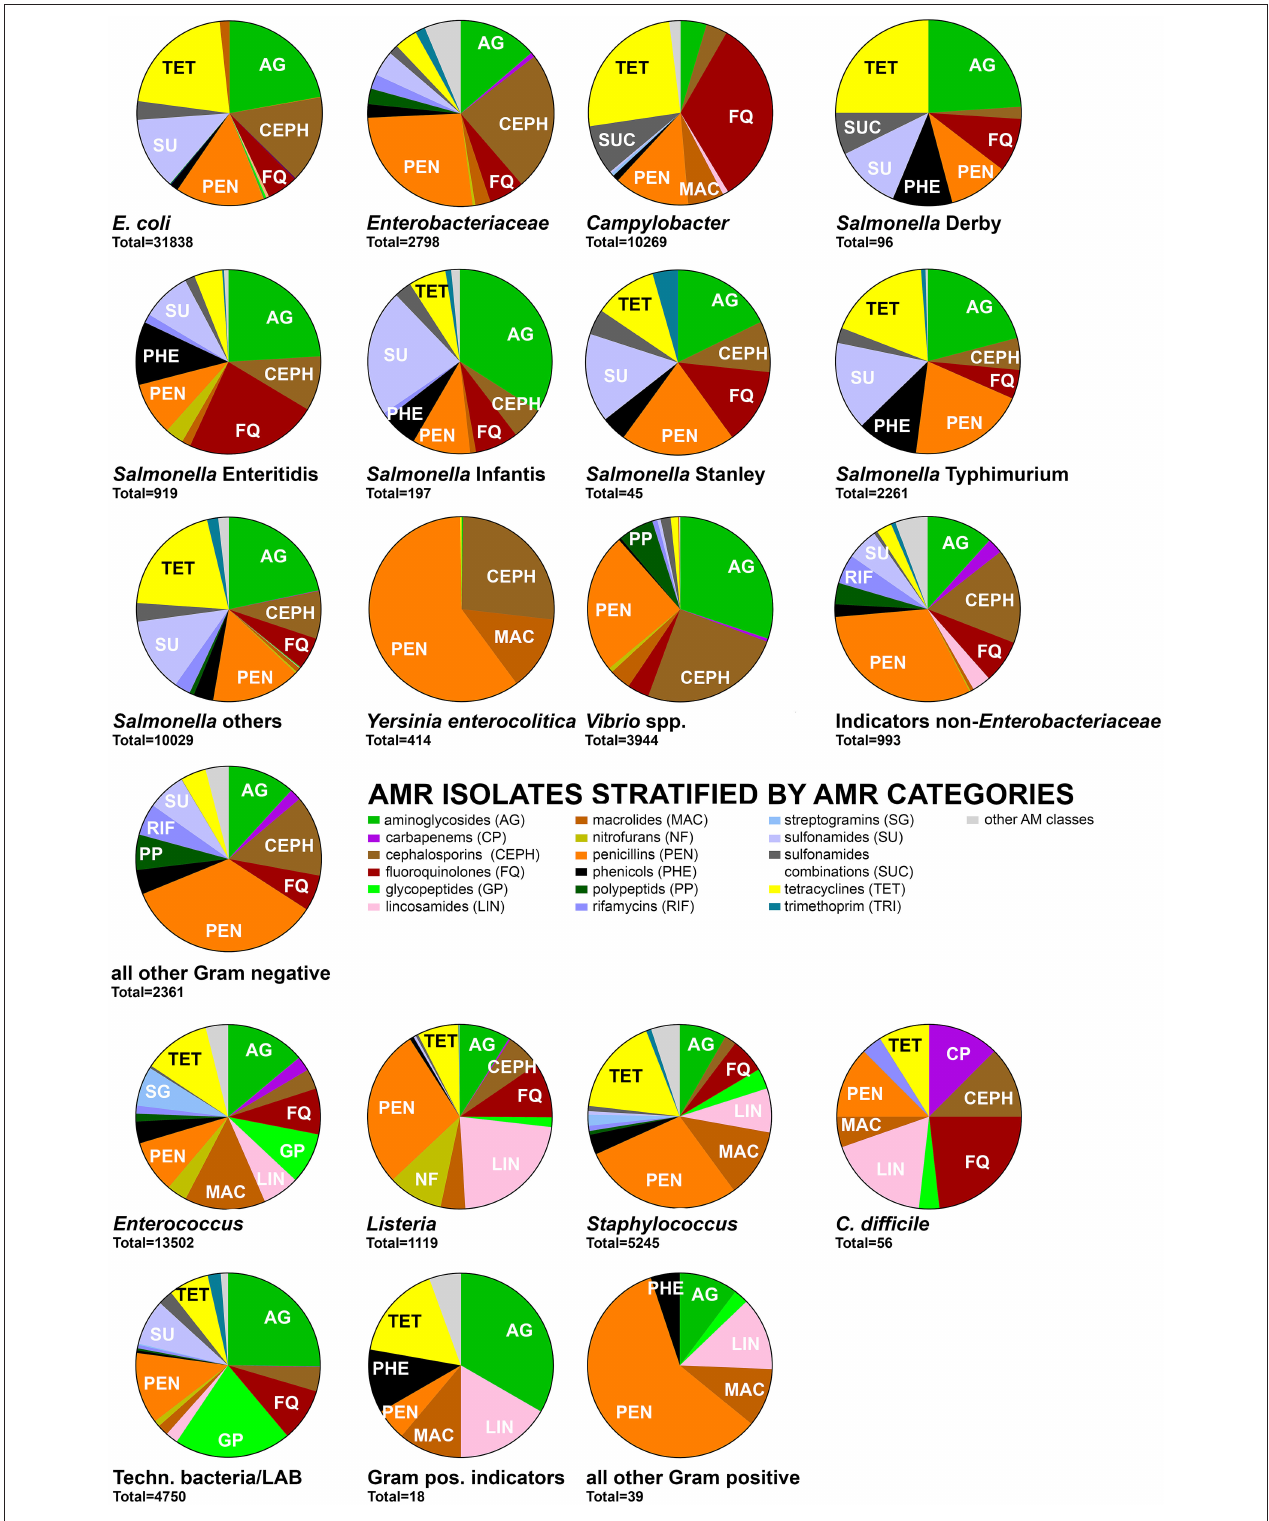
FIGURE 4 | Distribution of the number of AMR isolates of foodborne pathogens, indicator bacteria and technologically important bacteria by detected phenotypic AMR against 17 main AM classes. AM classes contributing ≥ 5% of AMR isolates per bacteria group are indicated in the pie chart. Data on AMR isolates for further AM classes are summarized under “other AM classes” and available in full in Supplementary Data Sheet 2. An isolate was counted once for each AMR determined.